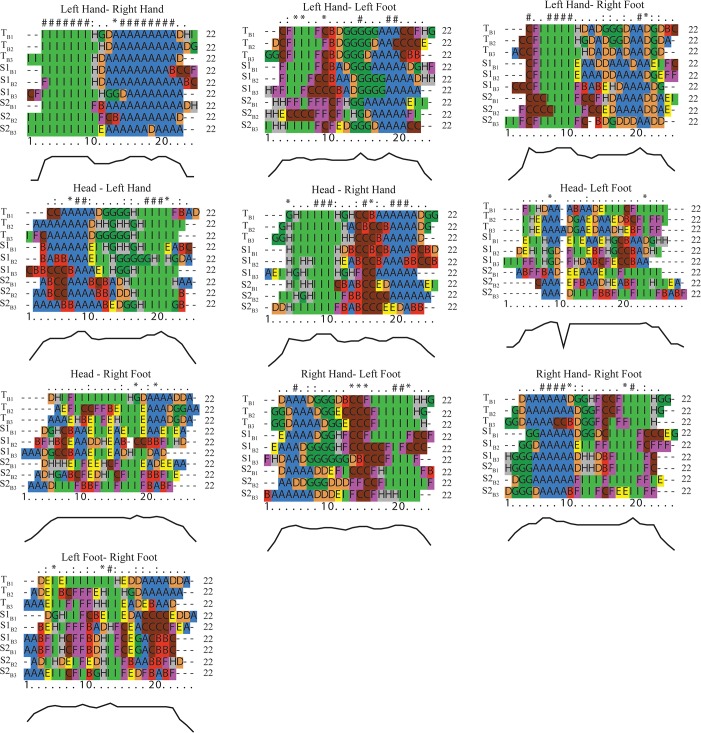
Multiple alignments of QTCB movement sequences based on the beats of the music.